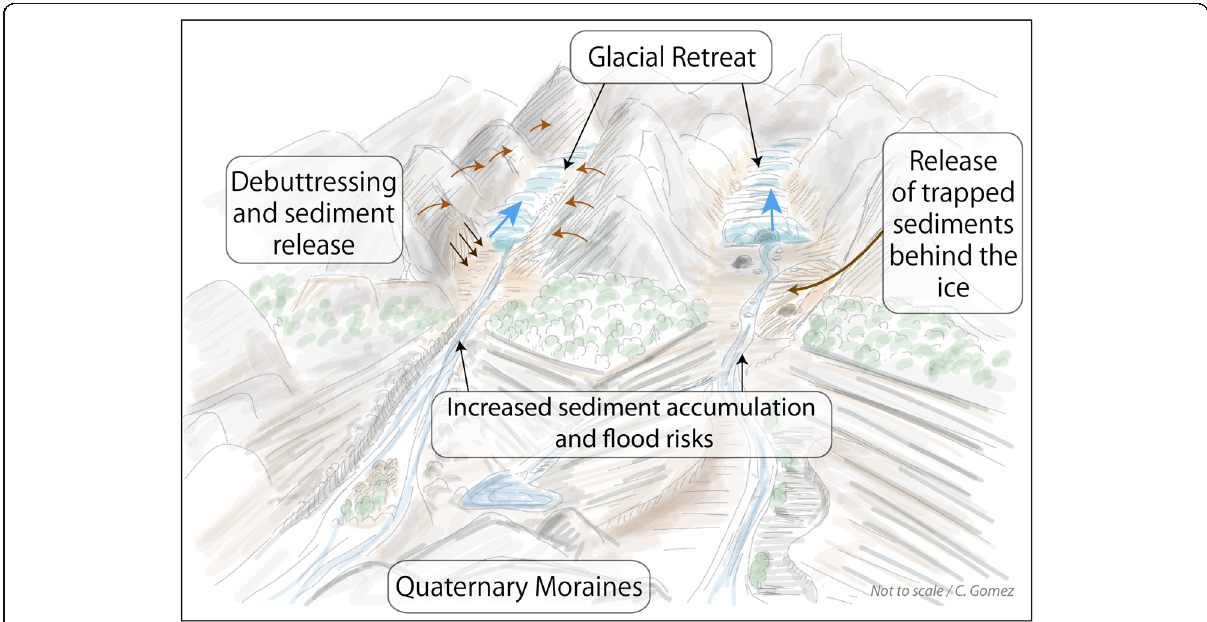
Fig. 1 Statement of one of the present issues in the deglaciating valleys of the West Coast of New